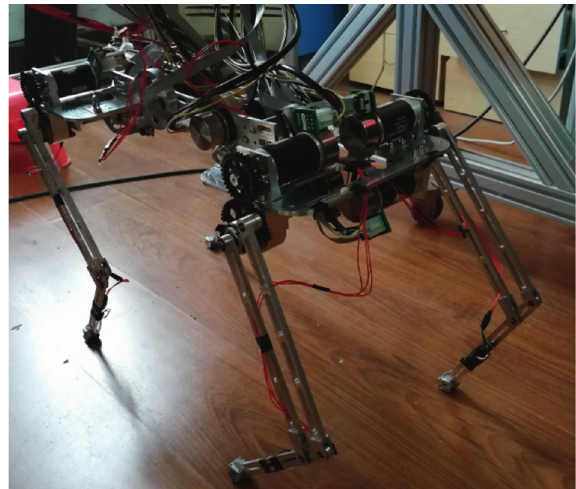
Figure 11: Quadruped robot with two spinal